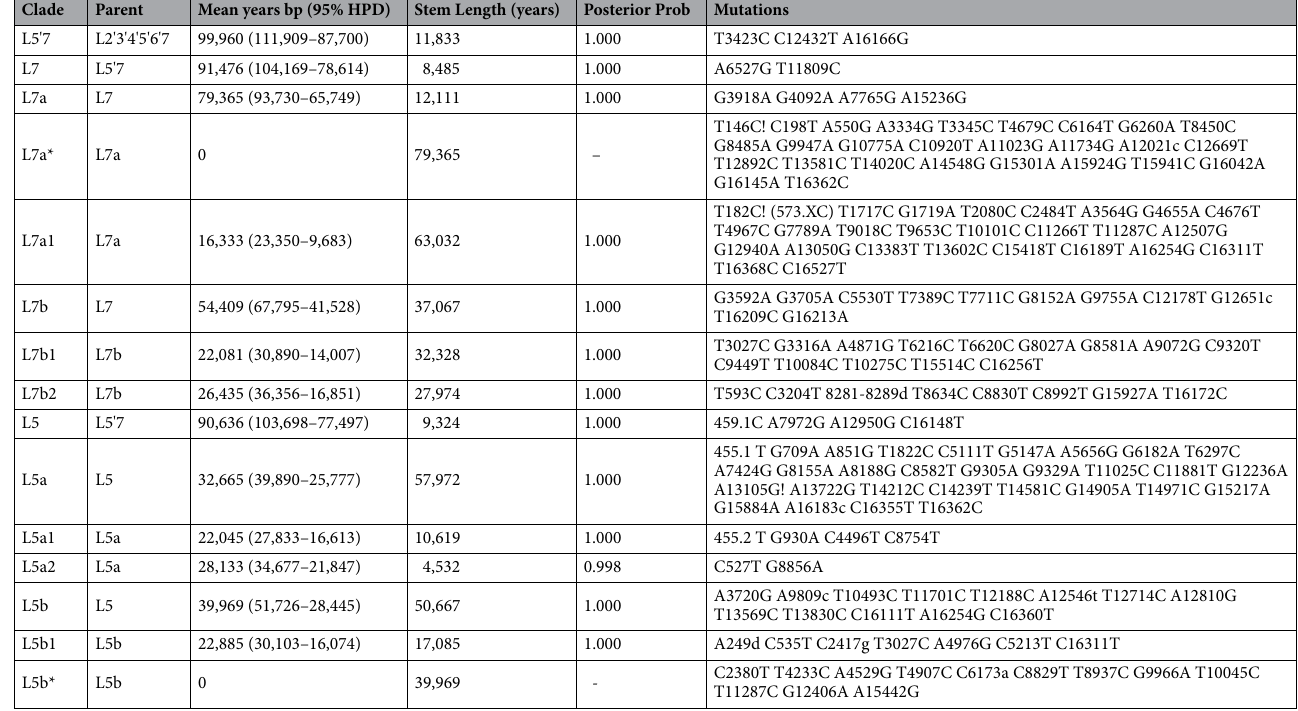
Table 1. Mean divergence estimates and mutations for major L5'7